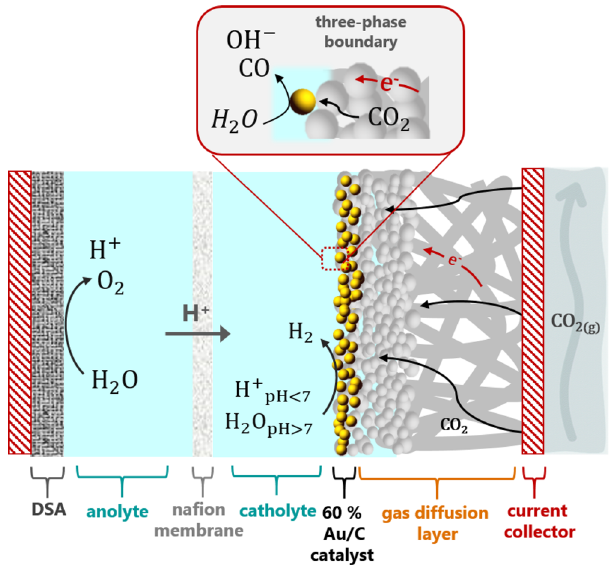
Fig. 1 CO 2 electrolysis. Schematic representation of the gold gas diffusion electrode system studied in this